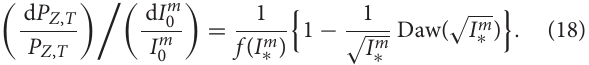
), spectral results by ∗